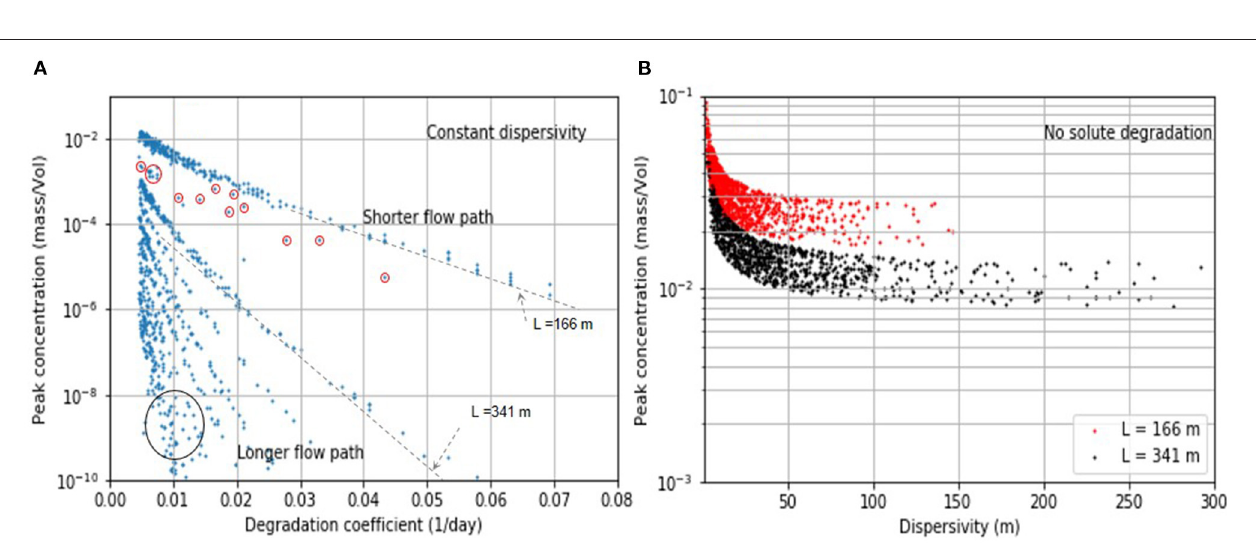
FIGURE 10 | (A) Peak concentration sensitivity to first-order degradation constant; (B) Peak concentration sensitivity to dispersivity.